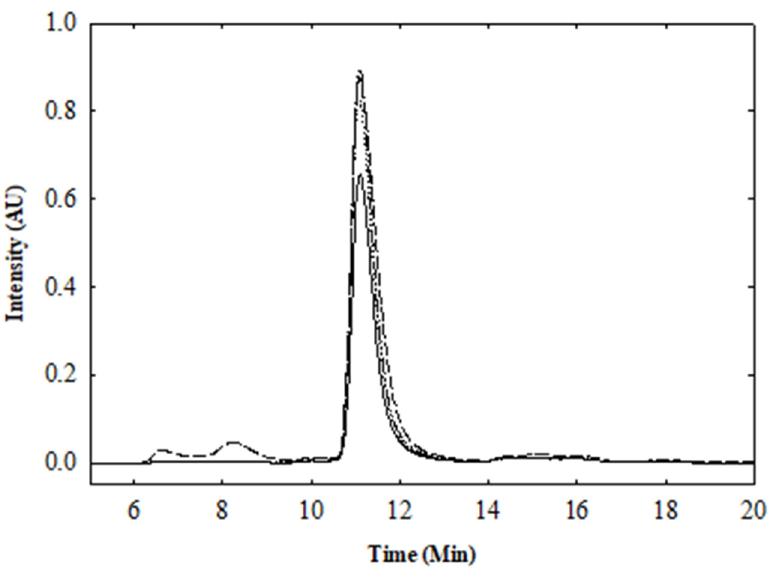
Figure 3. Size exclusion HPLC of purified HCV NS3. This assay was performed in a 0.1 M phosphate buffer at pH 6.7 by a flow rate of 0.3 mL/min using SEC column (BioSuite TM 125, 4 μ m HR SEC, 7.8 × 300 mm, Waters Corporation, Milford, MA, USA). All samples were eluted as a major 280 nm absorption peak (retention time near 12 min). The purified recombinant protein elution peaks of fresh 37 °C produced (-), fresh 25 °C produced (…), long-term-stored 37 °C produced (---), and long-term-stored 25 °C produced (-..), obtained in order.